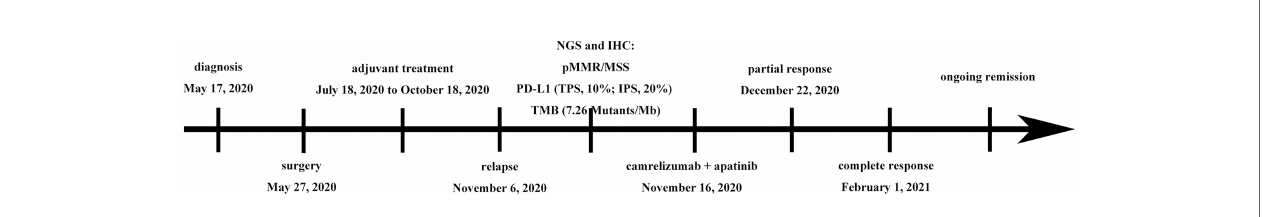
FIGURE 3 | Timeline of the clinical course in